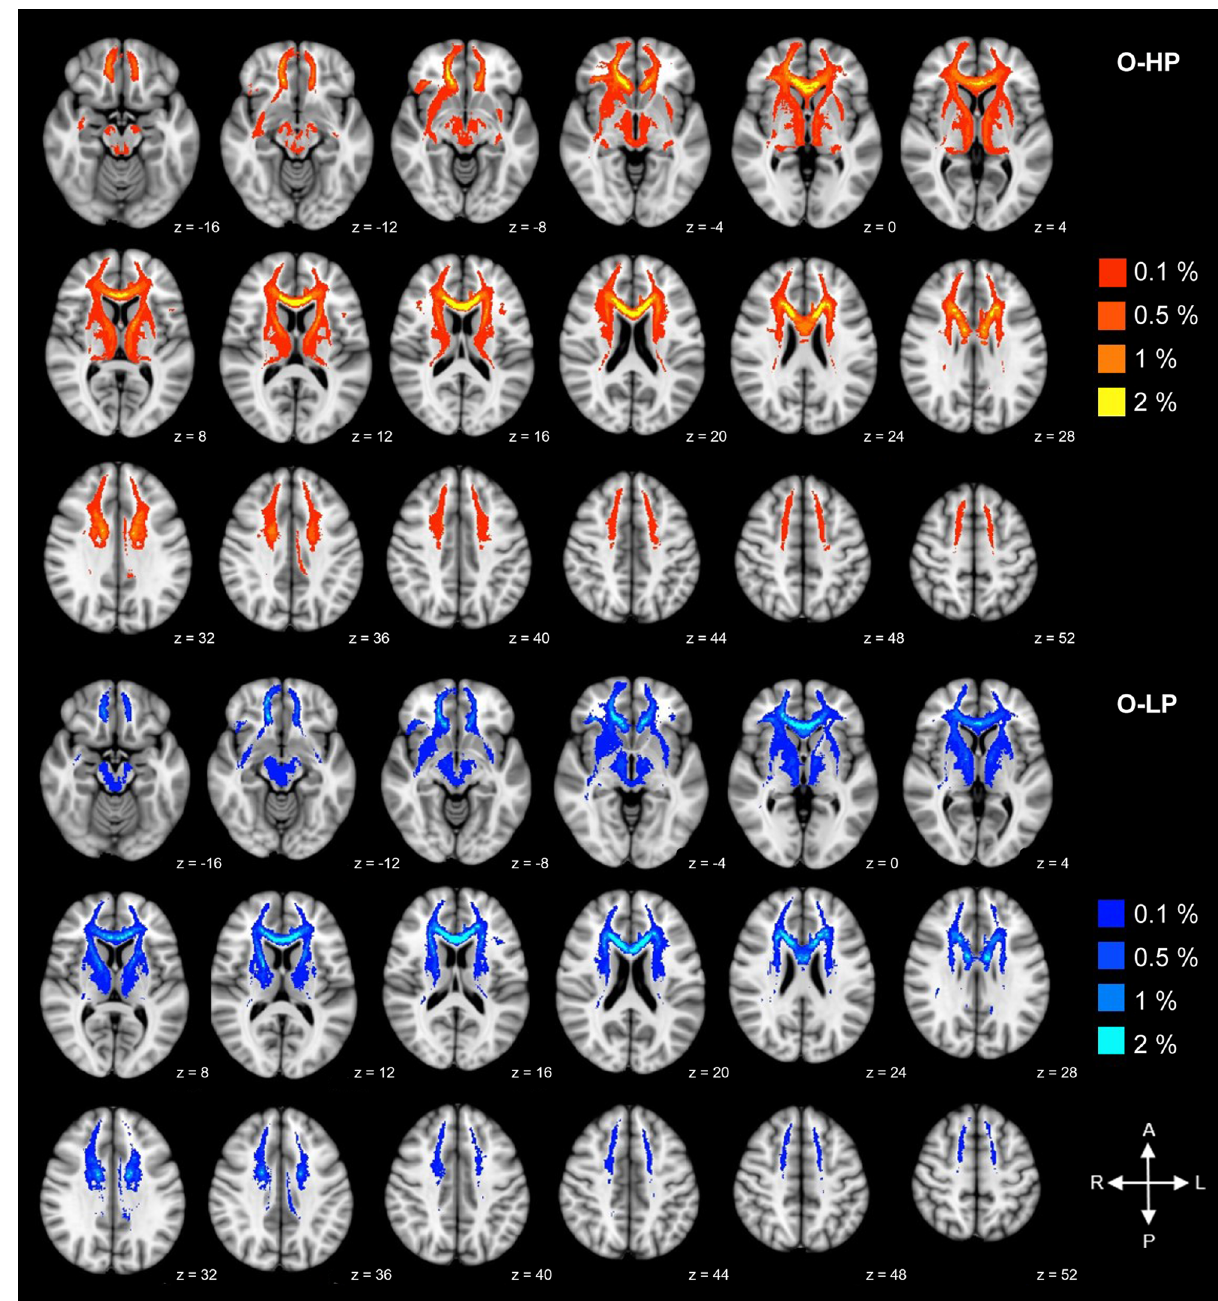
binarized group average tracts, thresholded by 50% for both groups. Individual tractography was conducted applying 5000 streamlines per voxel and thresholded by 0.1–2.0% of successful streamlines. The images are all in radiological